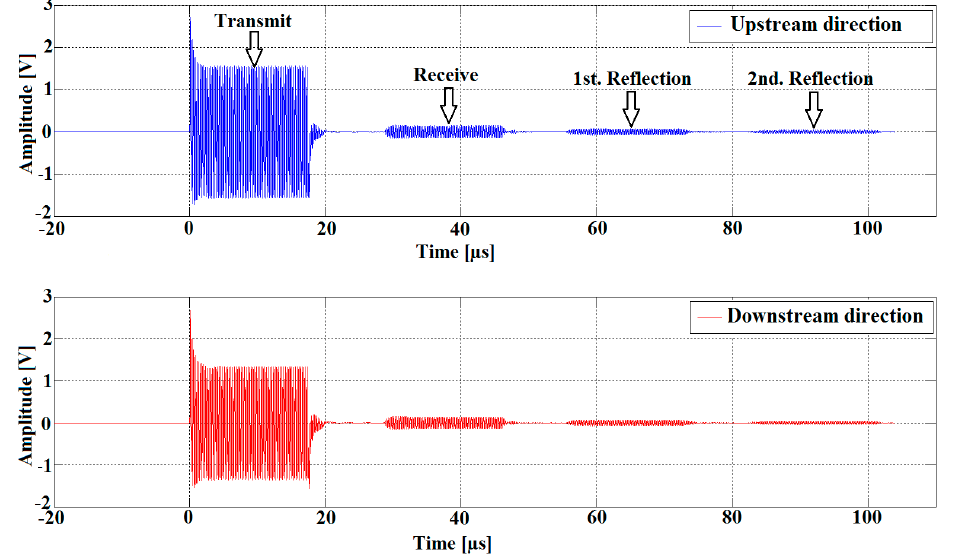
Figure 4. Acquired ultrasonic signals in the upstream and downstream directions (measured using a driving frequency of 4